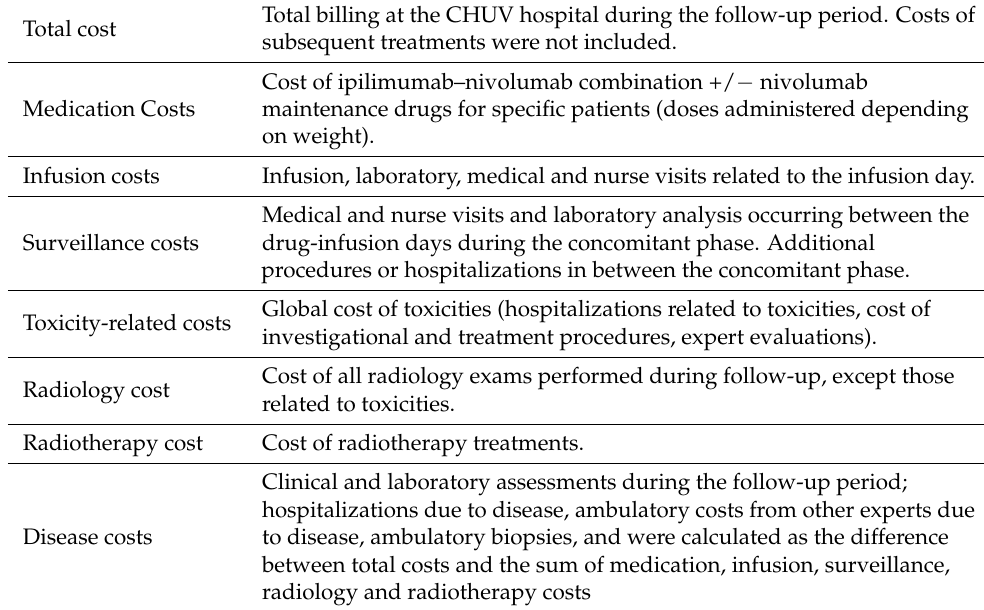
Table 1. Definition of cost categories used to estimate ipilimumab–nivolumab treatment-related